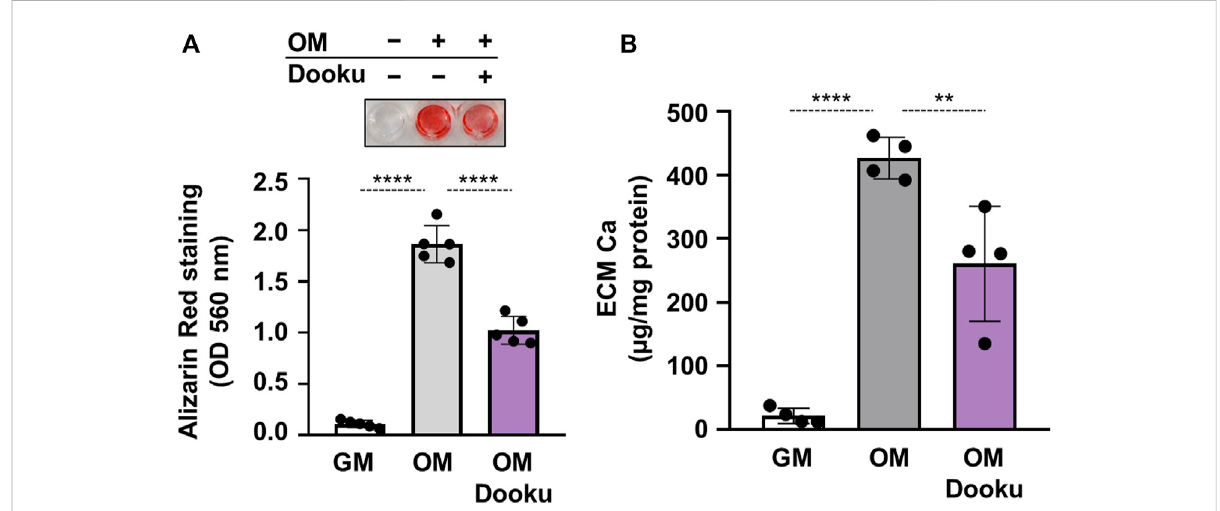
FIGURE 7 Piezo1 is critical in OM-induced HAoSMCs calci fi cation. (A,B) HAoSMCs were exposed to control medium (GM) or OM (excess P i : 1.5 mmol/L, excess calcium: 0.6 mmol/L) in the presence of Dooku (5 μ mol/L). (A) Representative Alizarin Red staining (day 6) and quanti fi cation. (B) Calcium content of HCl-solubilized ECM (day 6). Data are presented as mean ± SD, n = 4 – 5. ** p < 0.01, **** p <